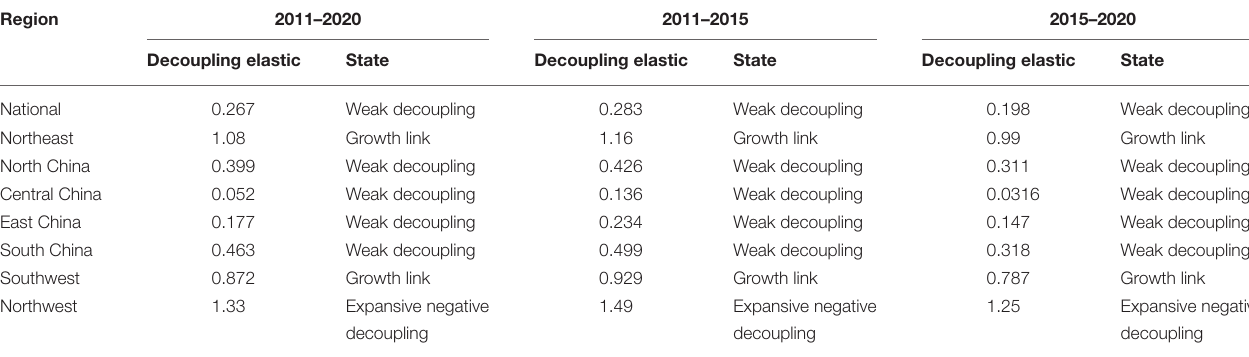
TABLE 5 | Decoupling of the efficiency of healthcare PPP projects and environmental pollution in China.